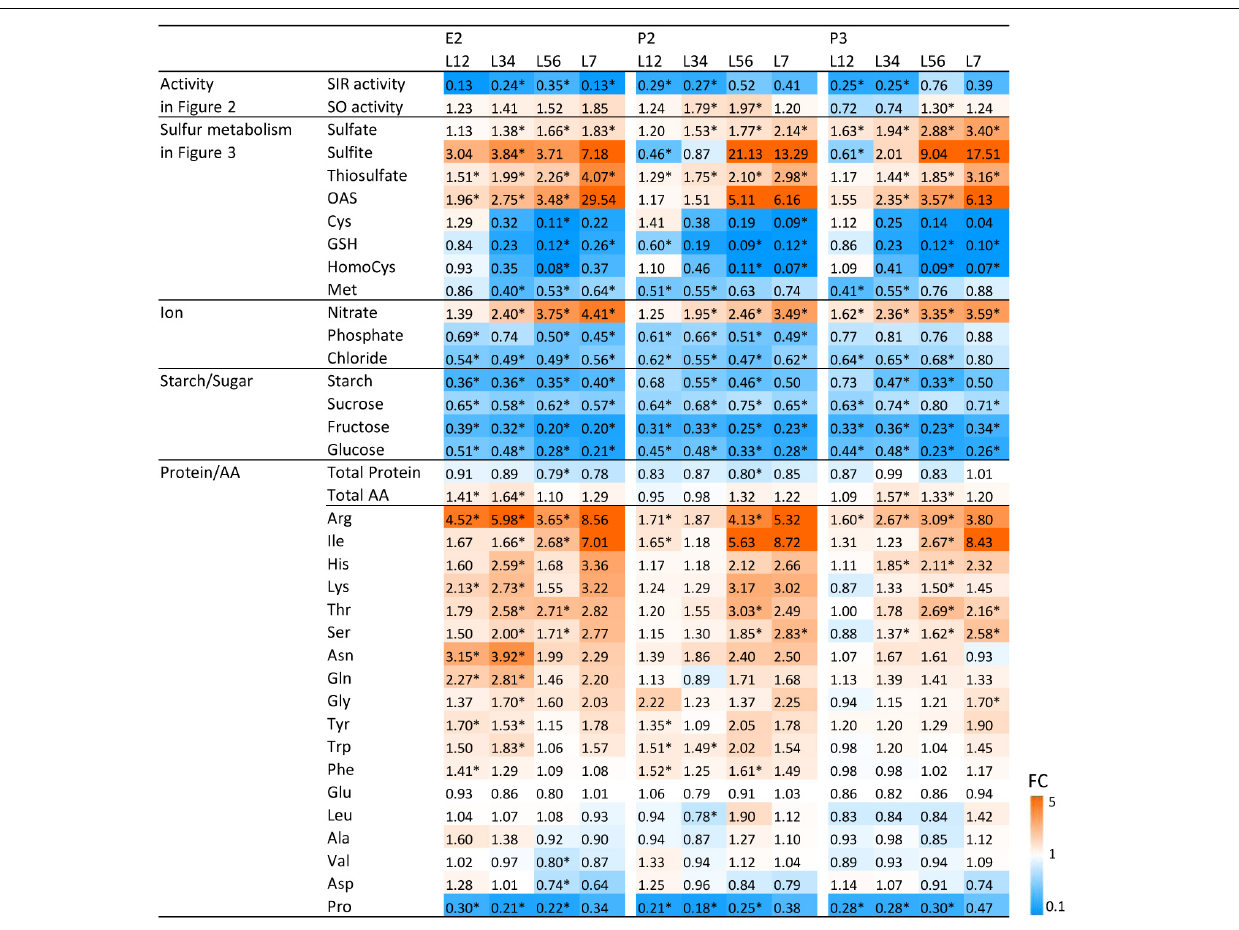
FIGURE 4 | Changes of SIR and SO activities and metabolites in the transgenic lines compared to wild-type plant. Contents of amino acids and thiols were determined by HPLC analysis and ions by ion chromatography. Contents of starch, sugars, total protein, total amino acid, and proline were determined by a 96-well platform (see materials and methods). The previously shown data ( Figures 2 , 3 ) were included. The ratios of fold changes from wild-type plants are given by shades of red or blue colors according to the scale bar. In order to generalize the datasets, we averaged sample results and fused the data pairwise from young to old leaves, i.e., L12 (L1 + L2), L34 (L3 + L4), L56 (L5 + L6), and L7. Data represent the mean ( ± SD) of 10 biological replicates for L12, L34, and L56, and five for L7. Differences between the wild-type and transgenic lines were analyzed using Student’s t -test and statistical significance was indicated ( ∗ P < 0.05). FC,